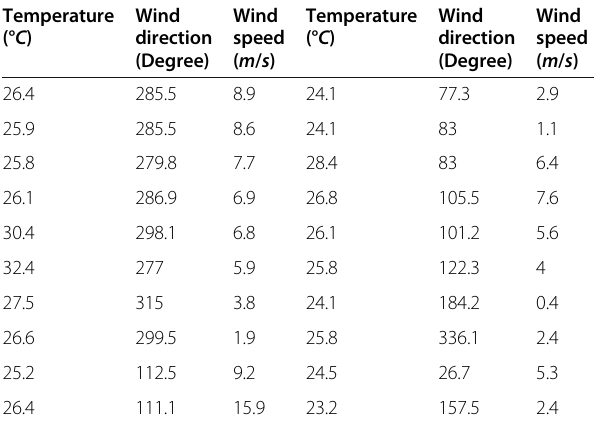
Table 3 Collected real-time inputs data sample (from Suzlon Energy Pvt. Ltd)